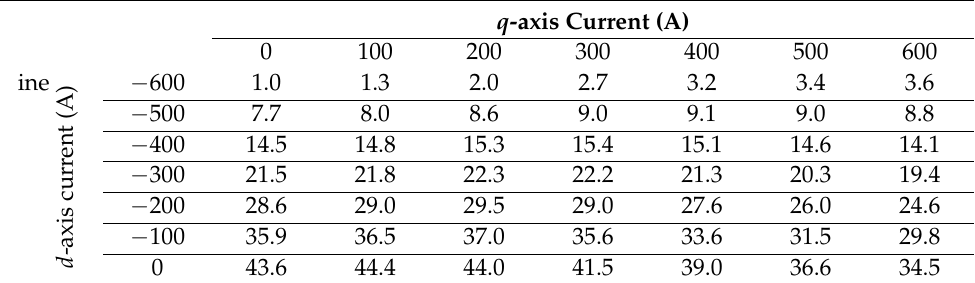
Table A4. Flux linkage in the d -axis calculated with the FEM model (mWb) (values averaged over one electrical period).